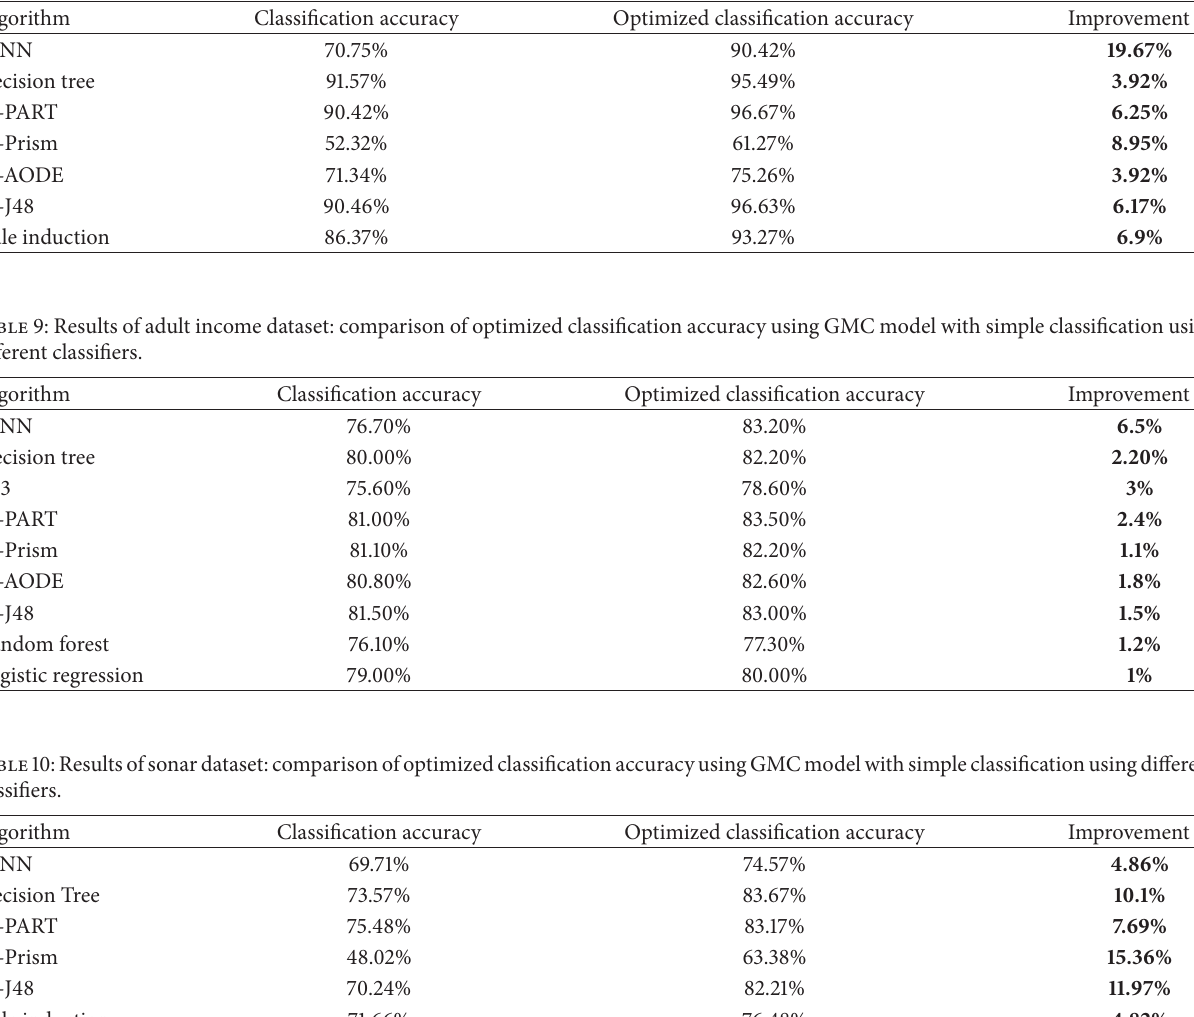
Table 8: Results of wine dataset: comparison of optimized classification accuracy using GMC model with simple classification using different classifiers.